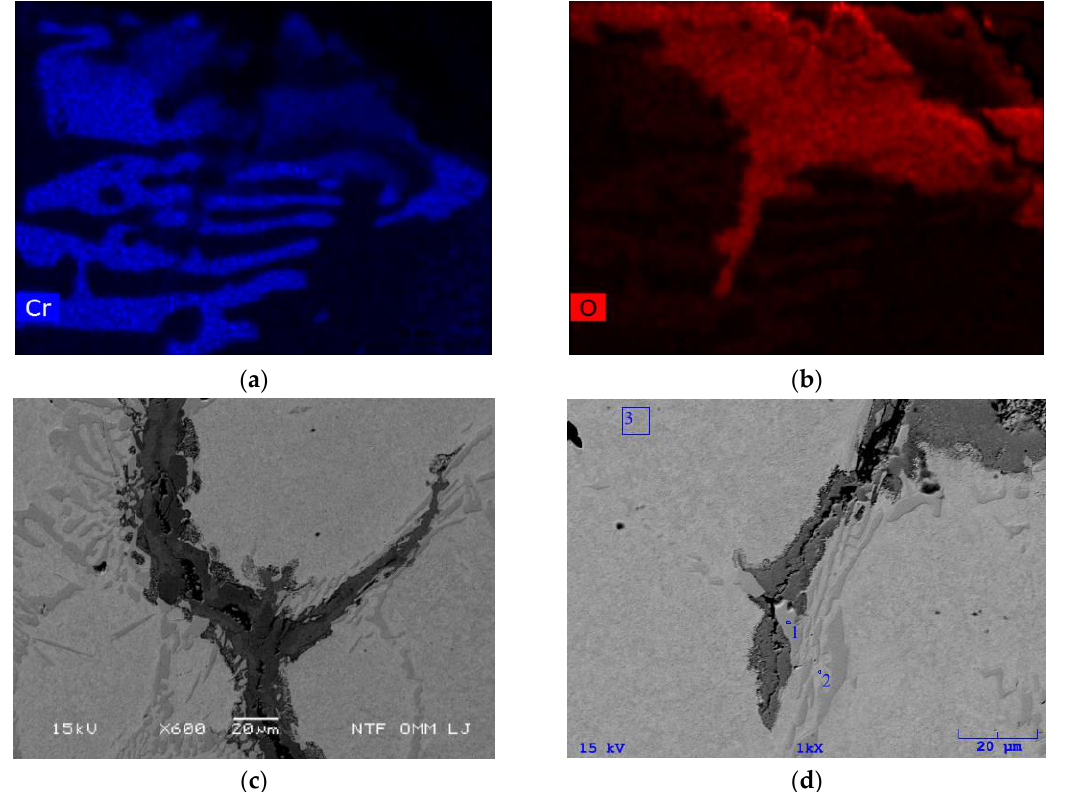
Figure 14. Oxidation of eutectic lamellae with smaller oxidation area oriented parallel to the cooled surface: ( a ) Distribution of Cr and ( b ) distribution of oxide tongues after 2500 cycles at 700 °C next to lamellae carbides; ( c ) detailed view of area A in Figure 10a with long oxidized tongues aligned 45° to the cooled surface and ( d ) long tongue next aligned approximately 70° to the cooled surface.